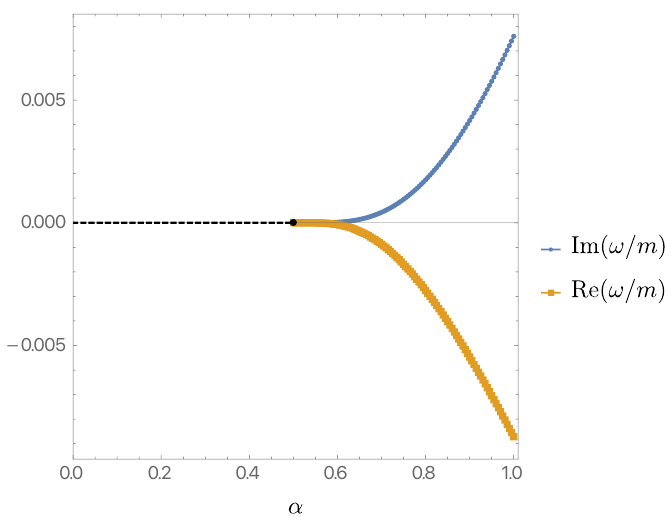
Figure 13 . Imaginary (blue disks) and real (orange squares) parts of ω as a function of α for fixed q/m = 0 . 5 and m r + = 1 . The frequency vanish for α ≤ 0 . 5 (black disk), in accordance to the AdS 2 BF bound condition given by (3.7) and the complementary analysis of section